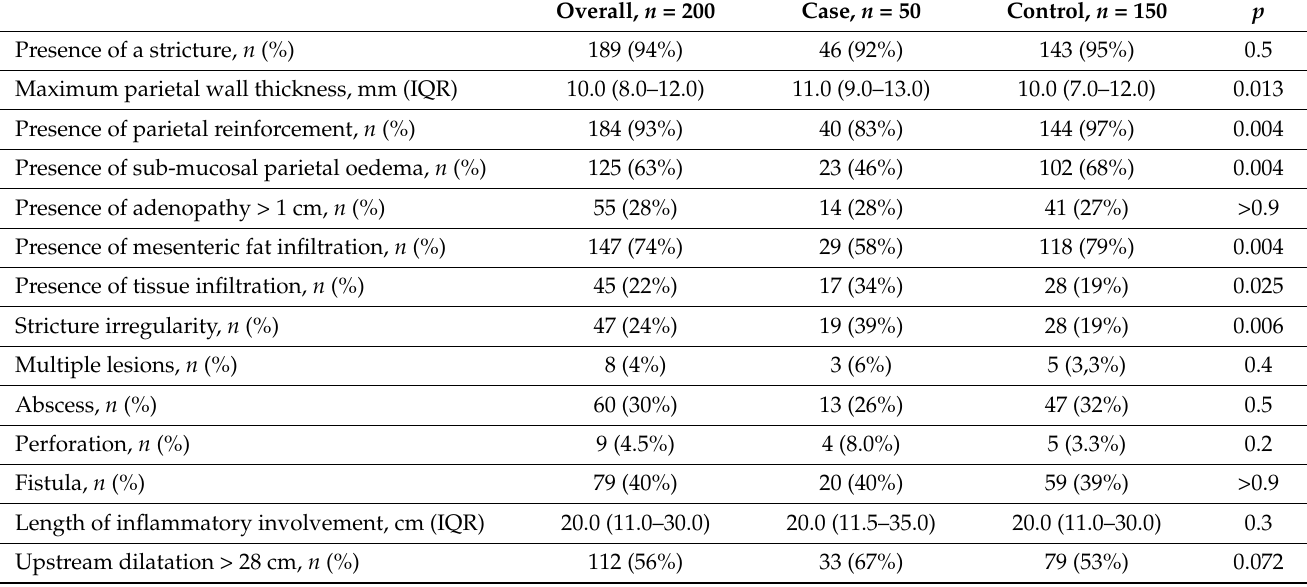
Table 3. Radiological analysis of baseline images’